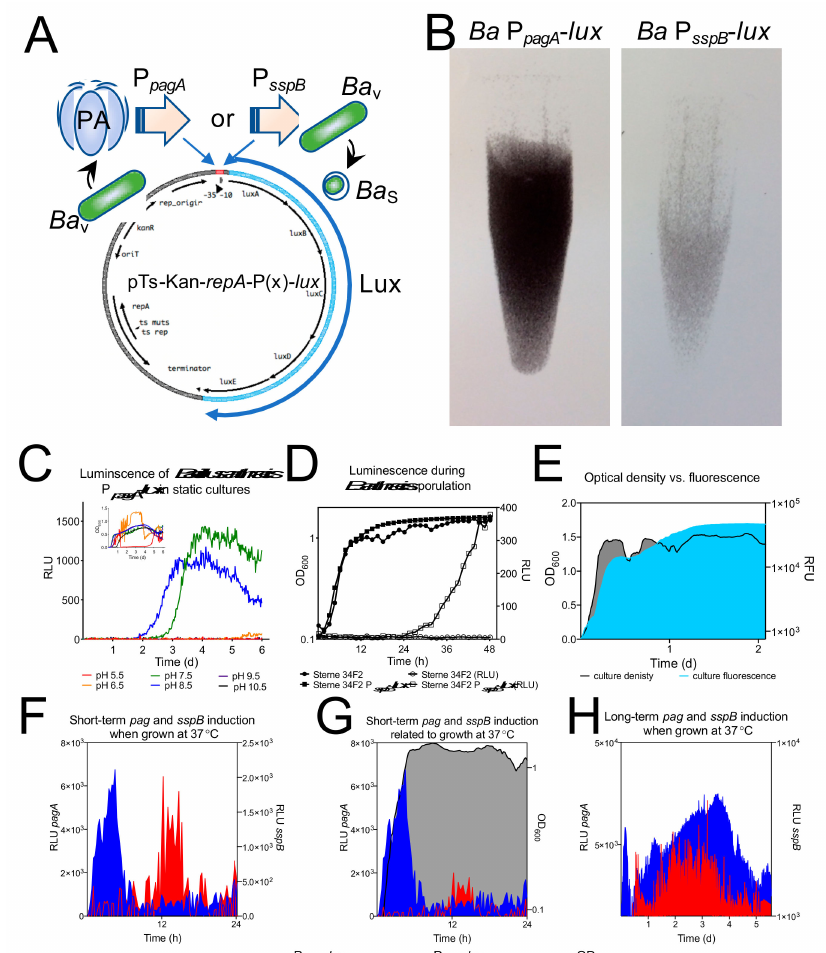
Figure 3. Tracking toxin elaboration and sporulation of B. anthracis. ( a ) A diagrammatic representation of the plasmid constructs used to track protective antigen (PA) induction from the pagA promoter (P pagA ) in vegetative B. anthracis ( Ba v ) or sporulation from the sspB promoter (P sspB ) in cells preparing to sporulate ( Ba s ) at 30 ◦ C. ( b ) A negative luminescent image of cultures grown in liquid broth for 24 h. The strength of expression of P pagA (left) compared to P sspB (right) is apparent in this image. ( c ) Static grown cultures of B. anthracis at 30 ◦ C show pagA expression measured in relative luminescent units (RLUs) is most optimal at pH 8.5 (blue line) and peaks at 3 days. ( d ) Luminescence (clear boxes) induced from P sspB during shaking growth (black boxes) at 30 ◦ C compared to B. anthracis luminescence without the plasmid (clear circles) and growth (black circles). ( e ) Validation of our dual-label AmCyan fluorescence indicator of B. anthracis growth at 37 ◦ C. Culture density measured by OD 600 (grey fill) compared to AmCyan relative fluorescent units (RFU; cyan fill). ( f ) Normalized short-term luminescent profiles from P pagA - lux and P sspB - lux expressing B. anthracis illustrates the temporally defined stages of toxin production and sporulation. ( g ) P pagA - lux and P sspB - lux expressing B. anthracis compared to OD 600 measurements. ( h ) Long-term luminescence of P pagA - lux and P sspB - lux expressing B. anthracis show that after an initial defined period of expression, a second less defined period and then increasing levels of luminescence follow, indicating continued cycles of toxin expression and sporulation in subpopulations of B. anthracis in long-term